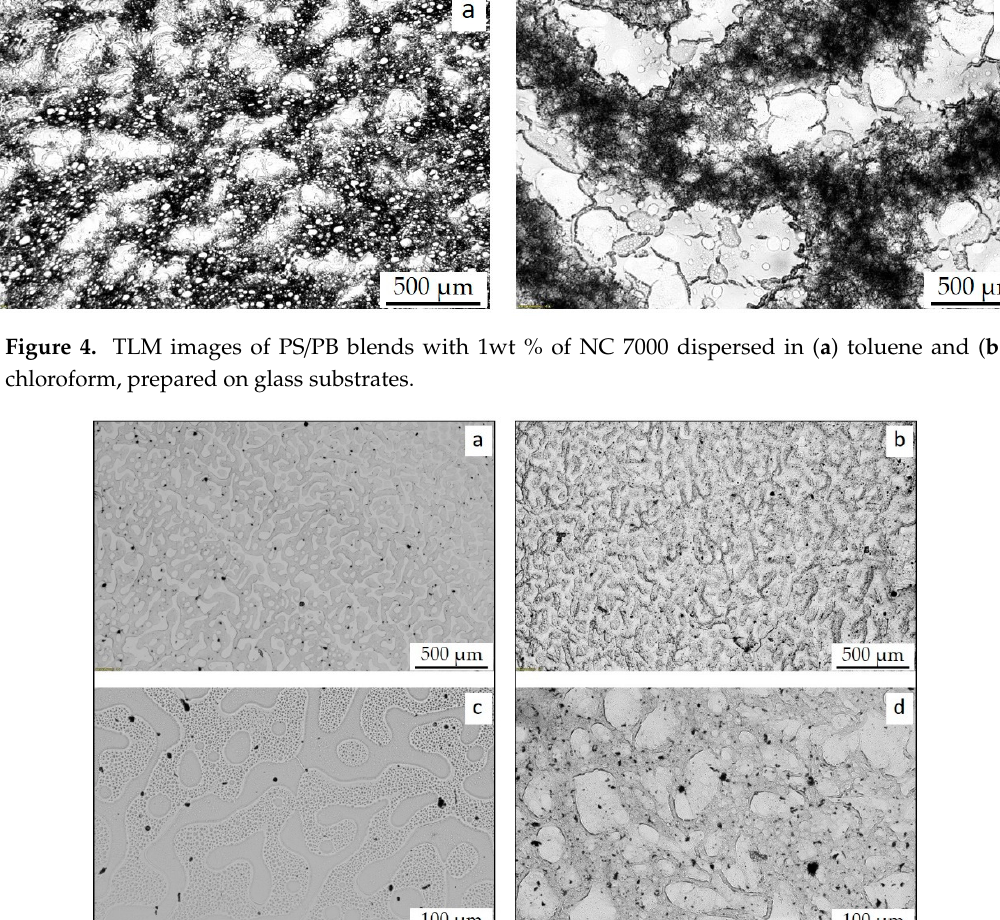
Figure 5. TLM images of PS/PB blends with 1 wt % of CNT-PS dispersed in toluene ( a , c ) and chloroform ( b , d ) prepared on glass substrates; ( c , d ) at higher magnification.